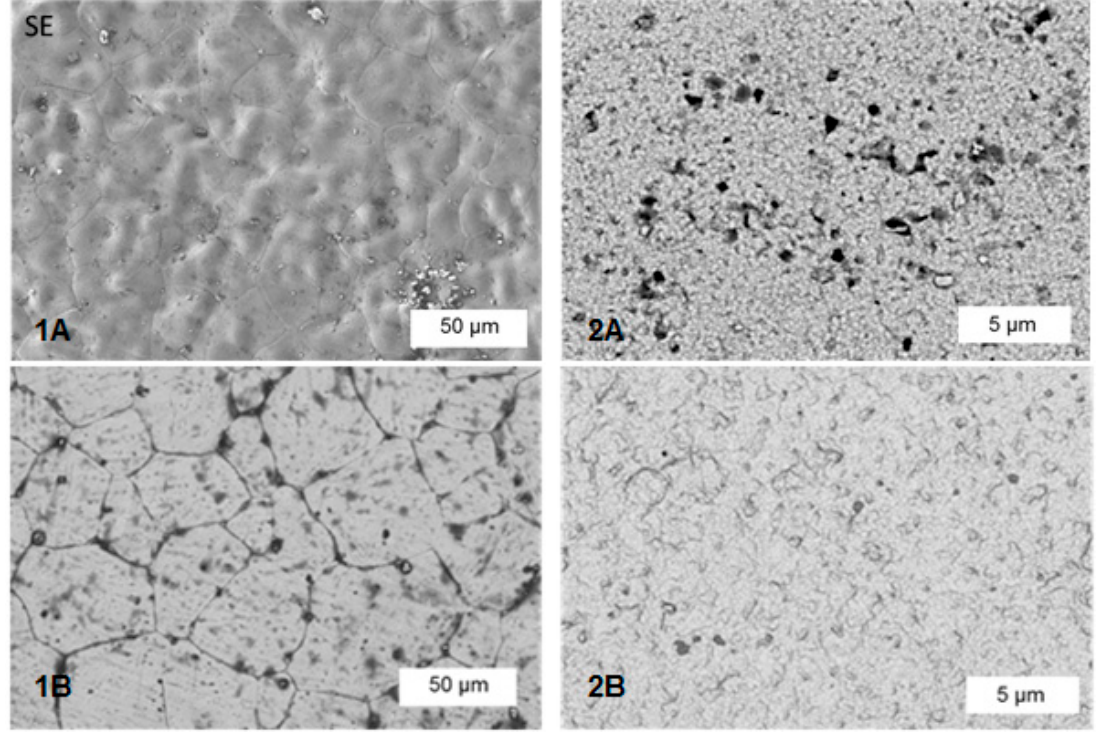
Figure 8. 17-4PH (1) and YSZ (2) surface of single tapes ( A ) and laminates ( B ) after 24 h hydrothermal corrosion.